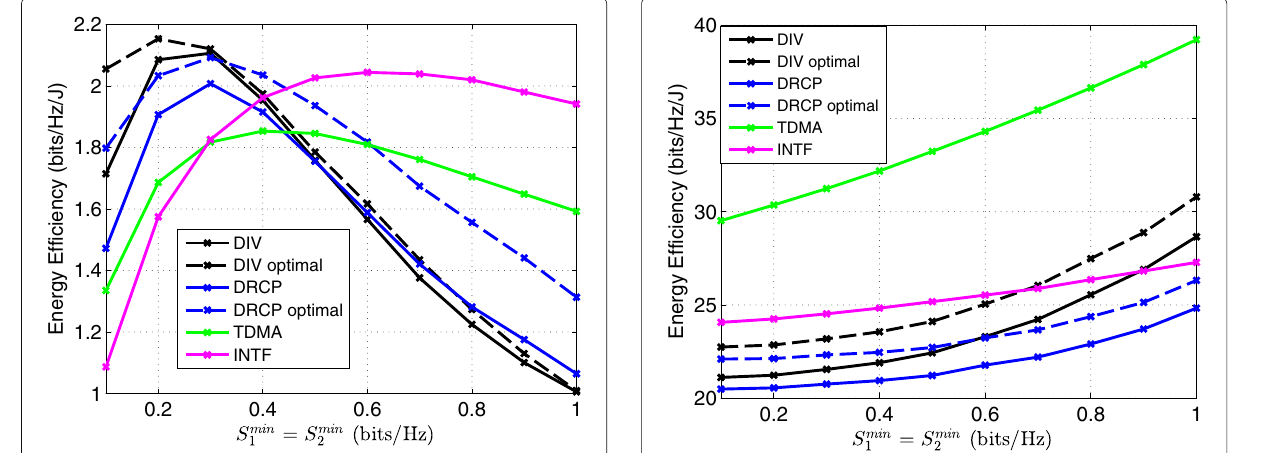
than DRCP when the minimum spectral efficiencies are minimum spectral efficiencies are large. This is because